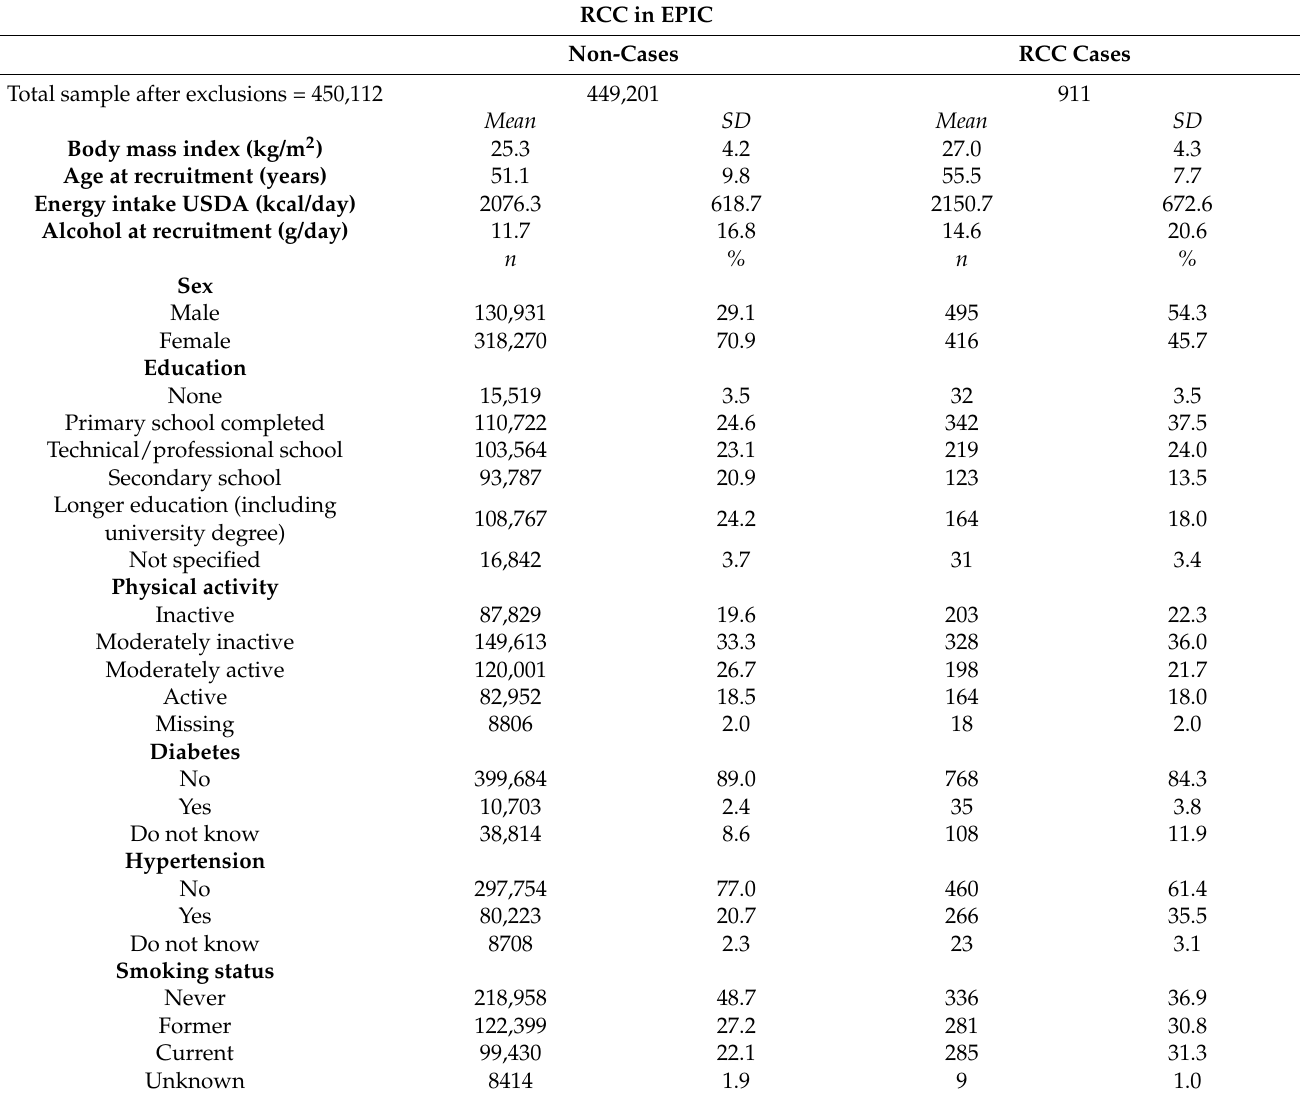
Table 1. Characteristics of EPIC participants included in the analysis of mycotoxin exposures and risk of RCC. RCC in EPIC